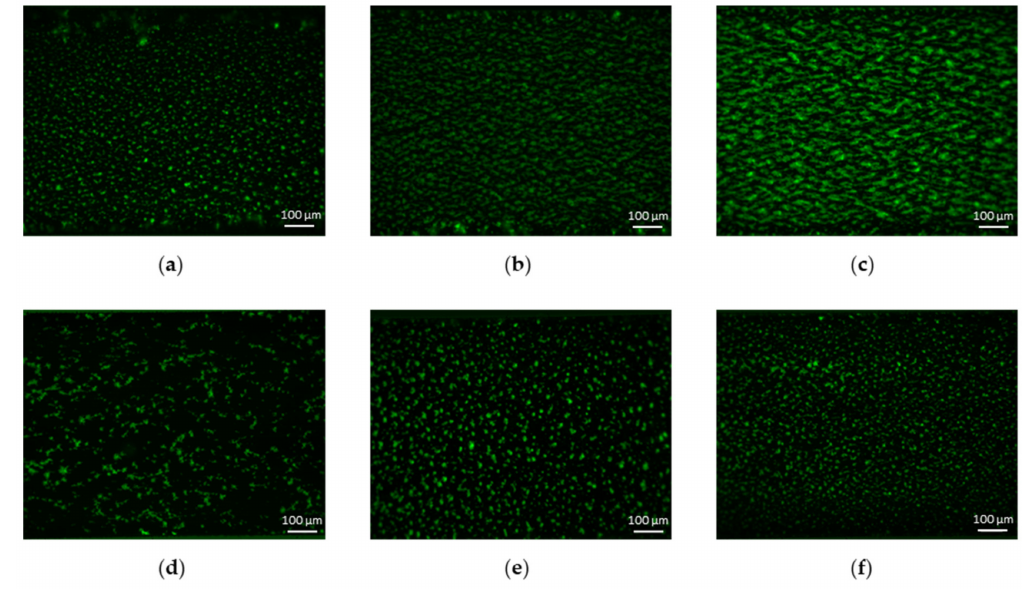
Figure 2. Representative images (6.3 × ) of platelet accumulation at di ff erent shear rates and collagen concentrations. Images are acquired after 4 min of perfusion. Flow is from left to right. The first row shows platelet accumulation over collagen (200 µ g / mL)-coated perfusion chamber at ( a ) 300 / s, ( b ) 1100 / s and ( c ) 1700 / s. The second row shows platelet accumulation at 300 / s for collagen concentrations equal to ( d ) 10 µ g / mL, ( e ) 50 µ g / mL and ( f ) 100 µ g / mL.